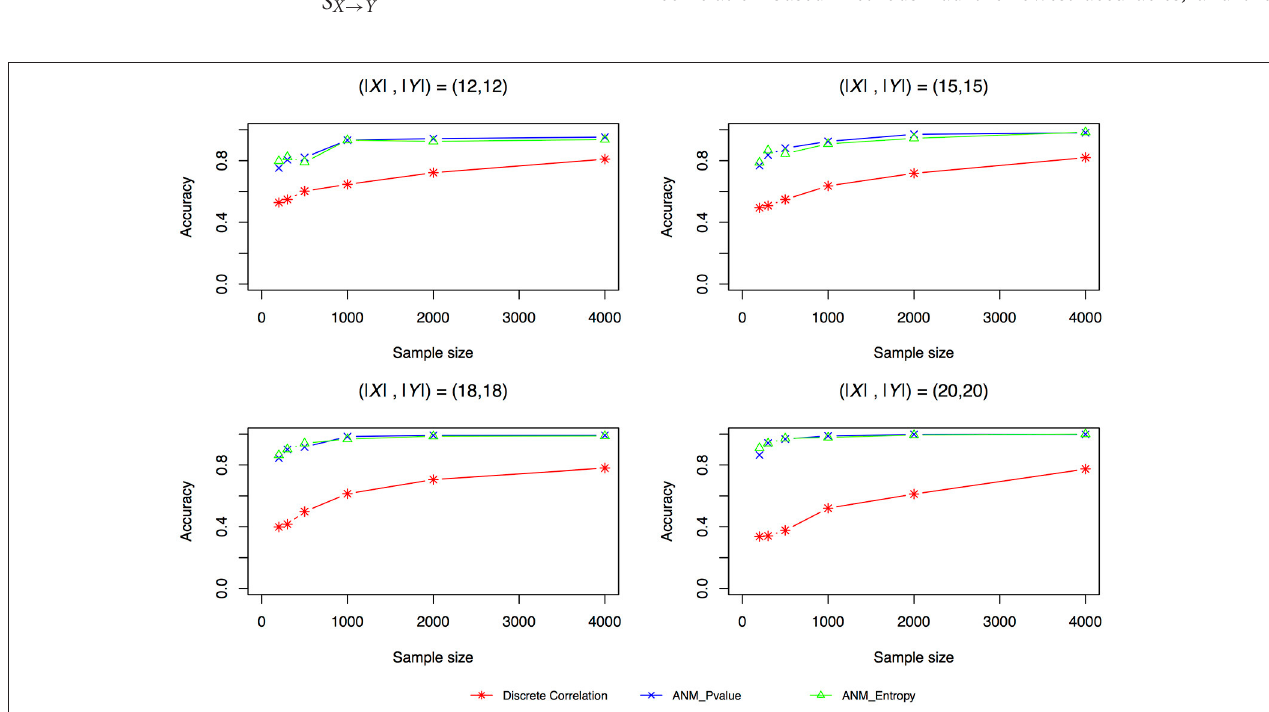
FIGURE 4 | Simulation scenario 1, (|X|,|Y|) (20,20).